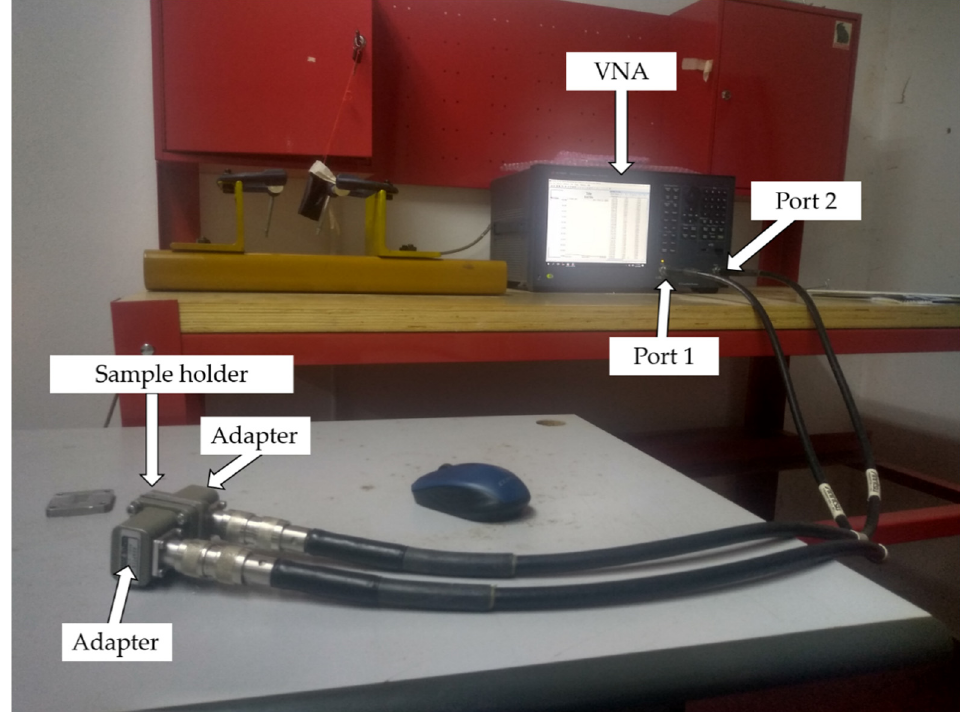
Figure 4. Measurement of complex permeability and permittivity using rectangular waveguide